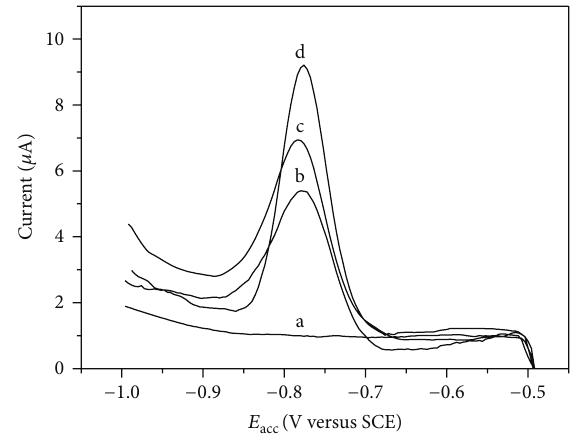
Figure 1: Square-wave stripping voltammograms recorded at the improved BiFE plated in 1molL −1 acetate buffer (pH 4.5) containing 0.08 mol/L trisodium citrate (a, b, and d) and the BiFE (c) plated in 1mol/L acetate buffer (pH 4.5) without trisodium citrate: (a) 0.1molL −1 HAc-NaAc (pH 4.8) + pyrogallol ( 1.3×10 −3 molL −1 ); (b) a + 10 𝜇 gL −1 Ge(IV); (c, d) b + 2 × 10 −4 molL −1 KBrO 3 ; deposition potential: − 0.34 V; deposition time: 150s; SW frequency: 25 Hz; scan increment: 4mV; pulse height: